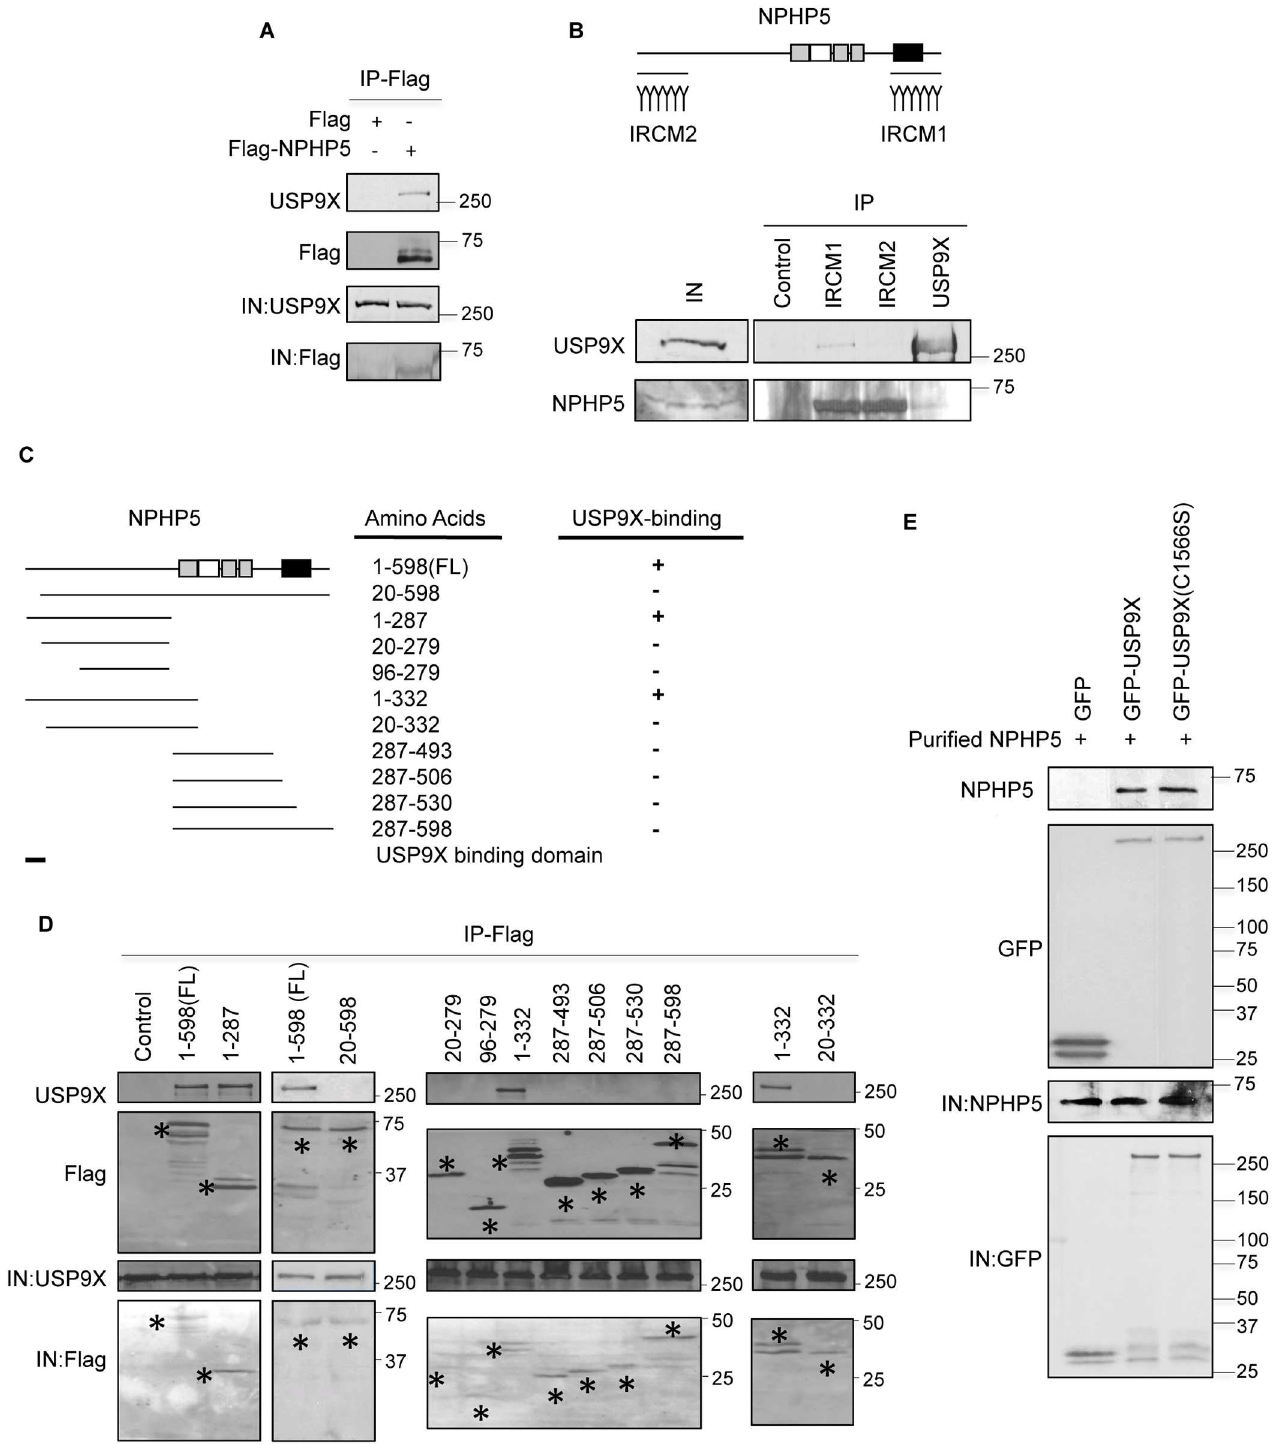
Fig 2. NPHP5 directly interacts with USP9X. A) Flag or Flag-NPHP5 was expressedin HEK293cells. Lysates were immunoprecipitatedwith anti- Flag antibody and Western blotted with the indicatedantibodies. IN, input. B) (Top) IRCM1 and IRCM2 are two anti-NPHP5 antibodiesraised againstthe C- and the N-terminus of NPHP5, respectively. Grey box, calmodulin-binding domain;white box, coiled-coil domain; black box; Cep290-bindingdomain.(Bottom) HEK293lysates were immunoprecipitatedwith anti-Flag (control), anti-NPHP5 (IRCM1 or IRCM2) or anti-USP9X antibody and Western blotted with the indicatedantibodies.IN, input. C) The ability of full-lengthNPHP5 (1-598(FL)) and various NPHP5 truncates